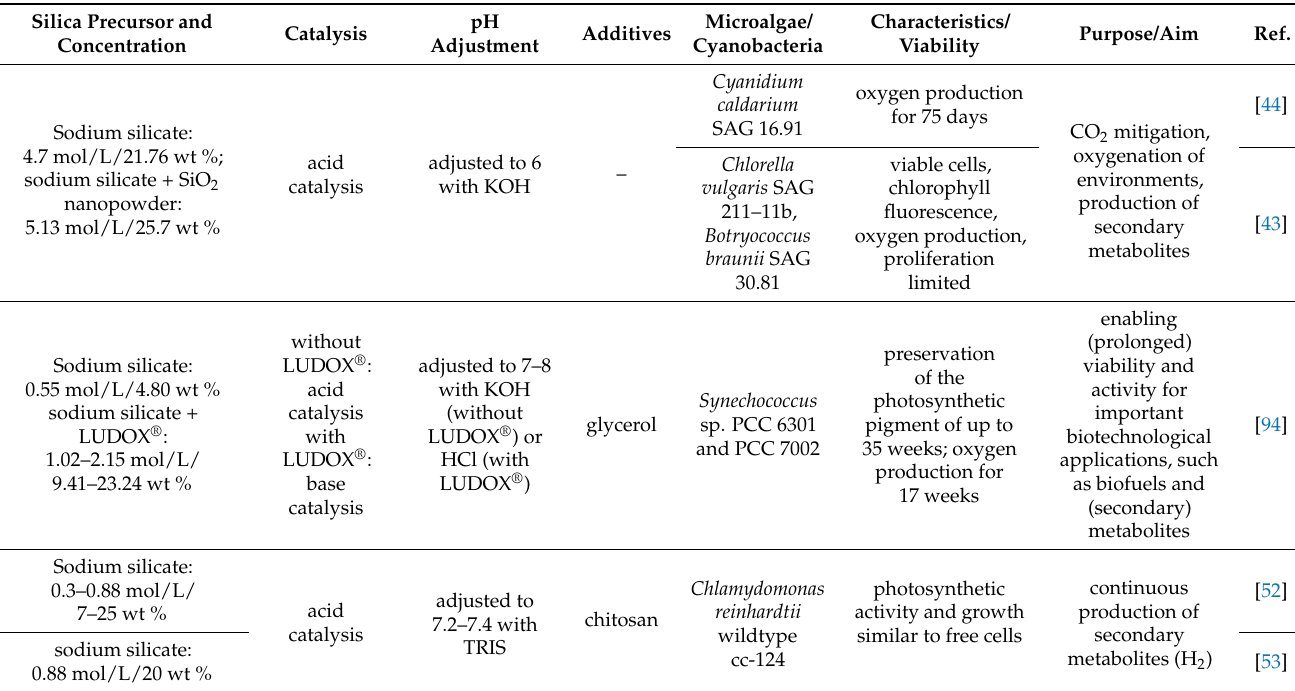
Table 3. Overview of microalgae entrapment in aqueous silicates with metal ion removal.